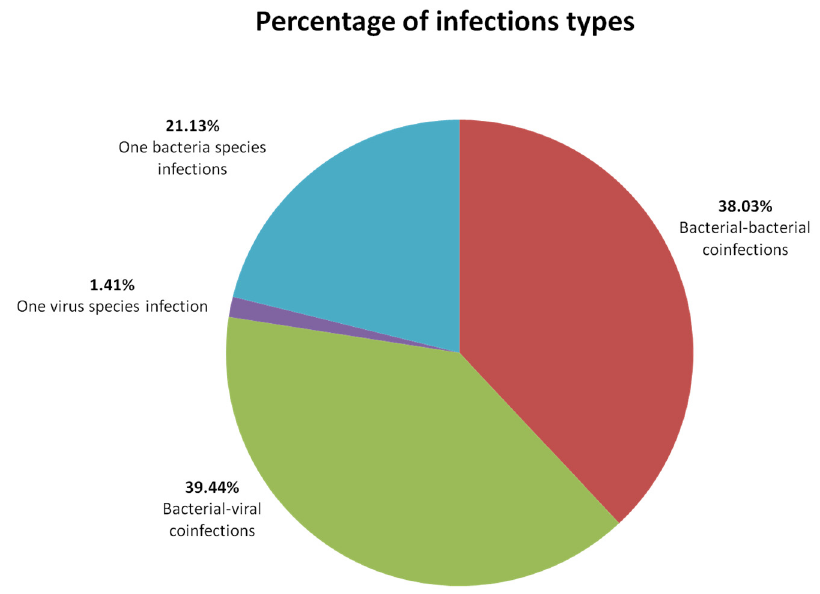
Figure 2. Percentage of infection types in positive results. Virus–virus coinfections were not detected.